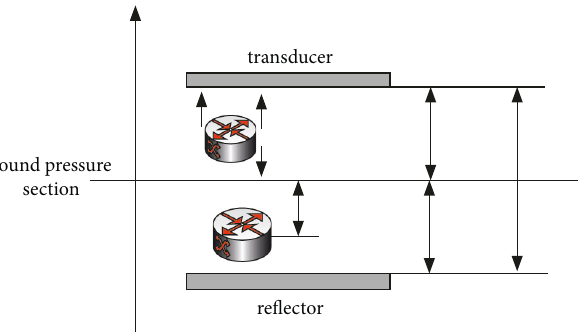
Figure 7: Physical model of ultrasound